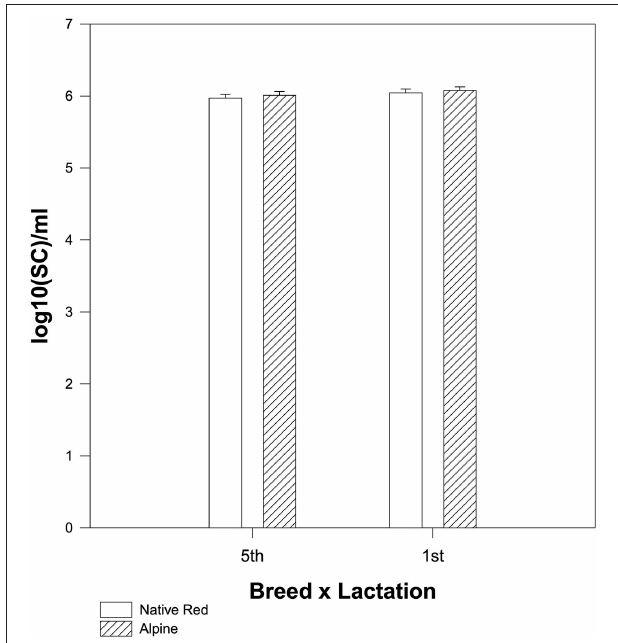
FIGURE 3 | The difference in mean values among the breeds depending on the lactation season for the somatic cell counts (SCCs). The interaction between breed and lactation was not significant for SC ( p =